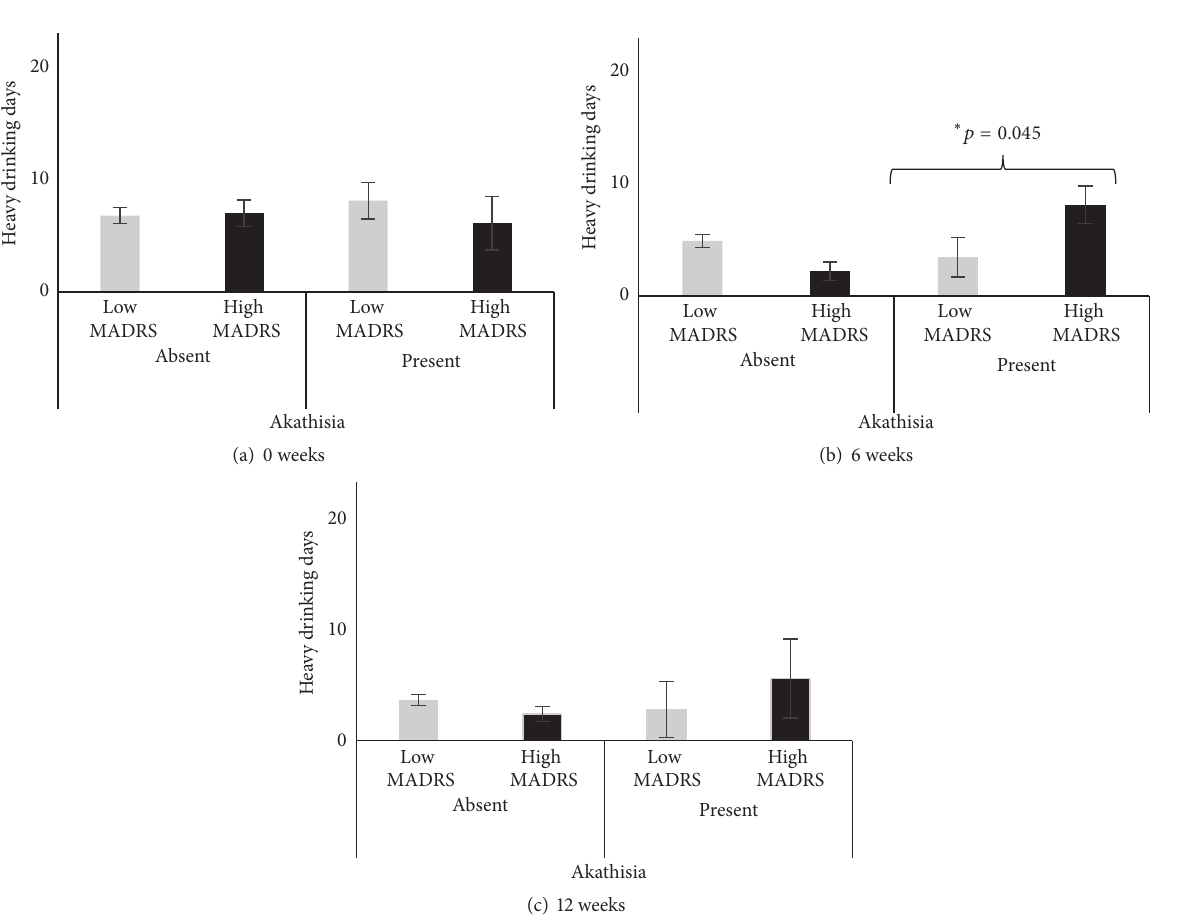
Figure 2: Frequency of heavy drinking days (HDD) in alcohol dependent patients by MADRS and reporting of akathisia. (a) Baseline (0 weeks) frequency of heavy drinking days (HDD30) by MADRS and akathisia. (b) Heavy drinking days (TD weeks 4–6) at week 6 by MADRS and akathisia. (c) Heavy drinking days (TD weeks 10–12) at week 12 by MADRS and akathisia. Data presented as M ± SE (mean with standard error). Significance was set at 𝑝 ≤ 0.05